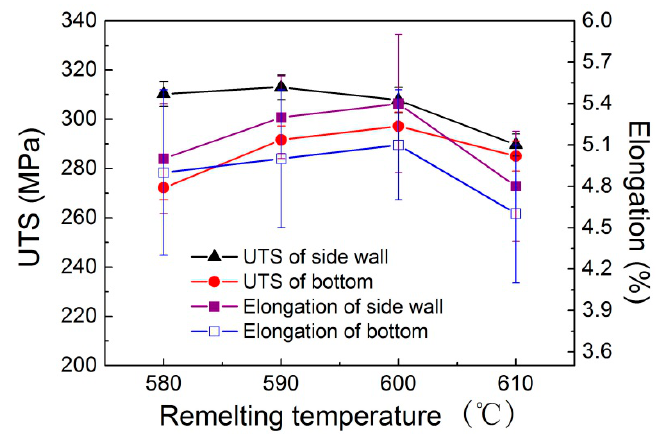
Figure 7. Mechanical properties of the thixoformed parts of the nano-sized SiCp/7075 composite soaked for 10 min at different remelting temperatures.